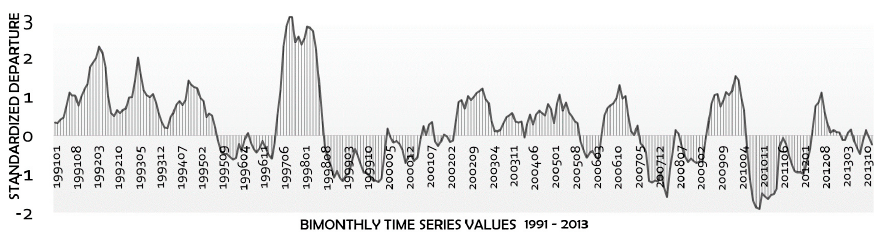
Figure 2. Bimonthly time series values of the Multivariate ENSO Index (MEI) from 1993 to 2012 used in this study. in this